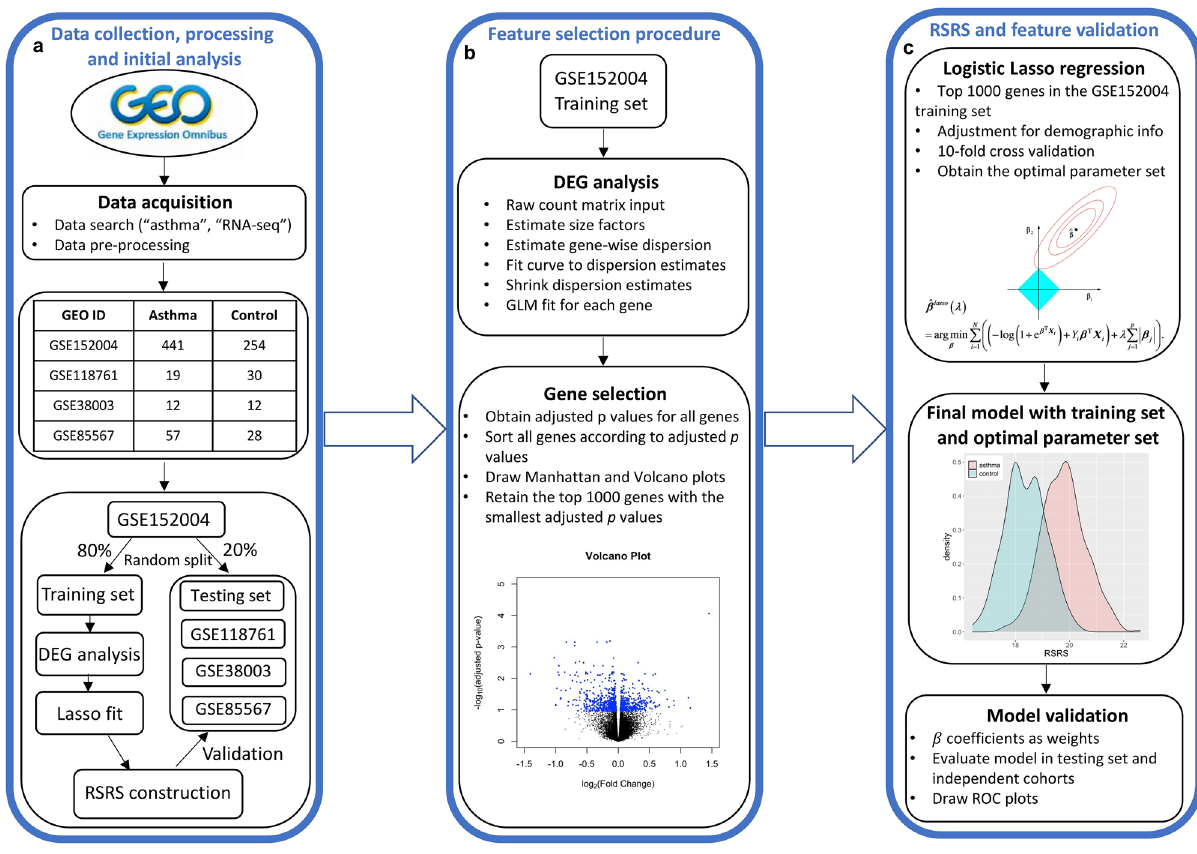
Figure 1. Study workflow for constructing the RSRS containing the steps of data acquisition and analysis. ( a ) Public data collection, processing and initial data analysis; ( b ) feature selection pipeline including DEG analysis and gene selection; ( c ) RSRS formulation and model validation in the testing set and independent